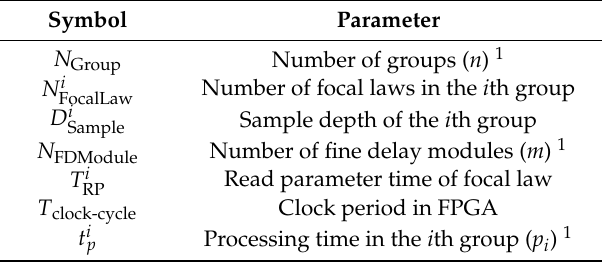
Table 1. Parameters of the fine delay module for multi-group scanning of a ultrasonic phased array (UPA) system.